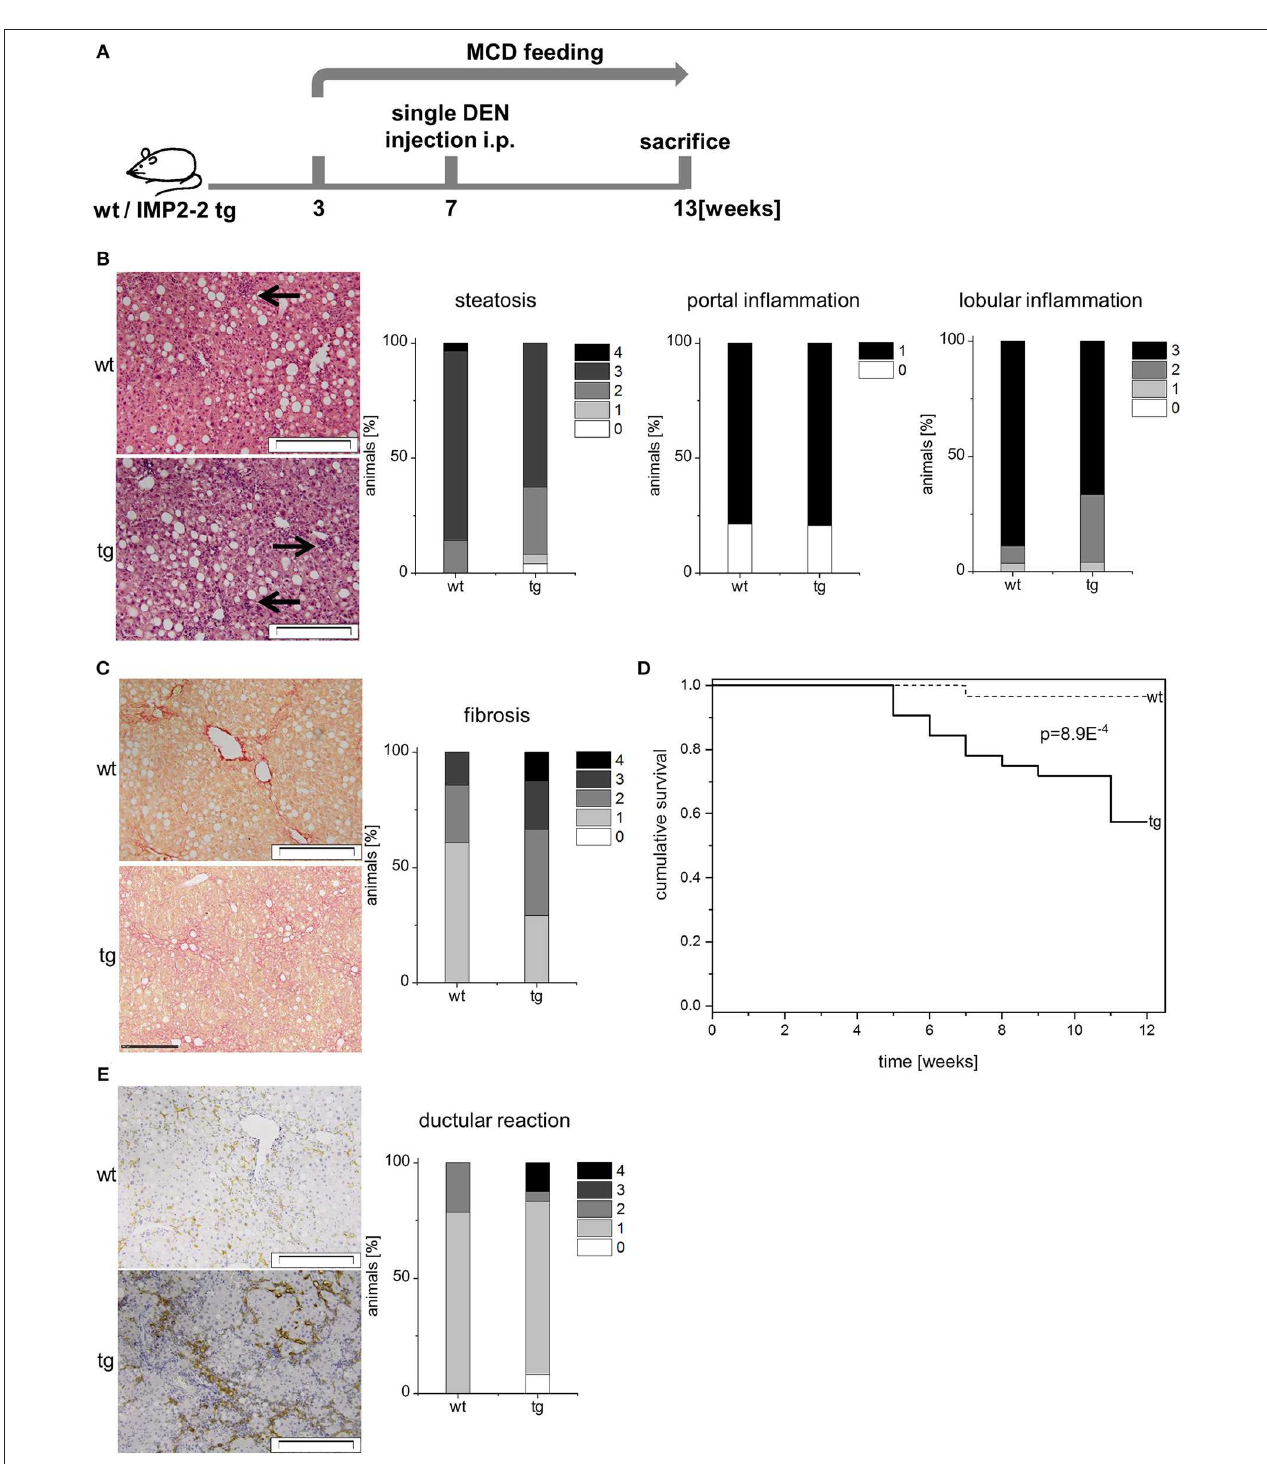
FIGURE 7 | Transgenic expression of IMP2-2 leads to shorter survival in the MCD-DEN model. (A) Treatment scheme of the MCD/DEN model. Administration of DEN 5 weeks after the onset of MCD feeding (MCD-DEN). (B) Representative images of HE (left) and histological scorings for steatosis, lobular and portal inflammation of wt and tg mice treated with MCD-DEN (wt: n = 28, tg: n = 24). Arrows indicate inflammatory foci (scale bars: 50 µ m). (C) Representative images of Sirius Red staining (left) and histological scoring for fibrosis (right) of wt and tg mice treated with MCD-DEN (wt: n = 28, tg: n = 24) (wt: score 1; tg: score 3; scale bars: 50 µ m). (D) Kaplan-Meier survival plot referring to wt and tg animals treated with MCD-DEN (wt: n = 28, tg: n = 24). (E) Representative images of KRT19 staining (left) and histological scoring for DR (right) of wt and tg mice treated with MCD-DEN (wt: n = 28, tg: n = 24) (scale bars: 200 µ m).